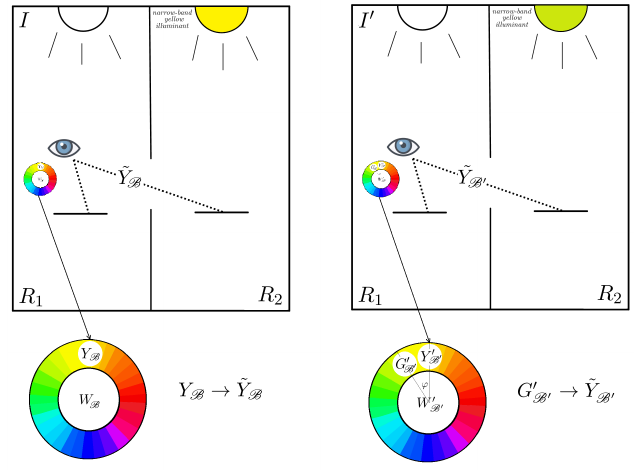
Figure 7. Depiction of Yilmaz’s third experiment with the notation established in Section